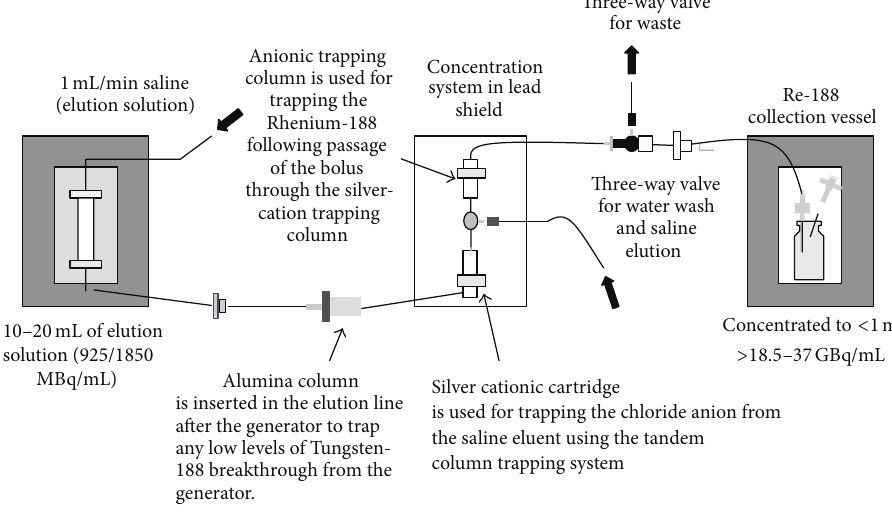
Figure 4: Schematic drawn of 188 Re generator and concentration system with of IC-Ag and Sep-Pak Accell Plus QMA anion exchanger column